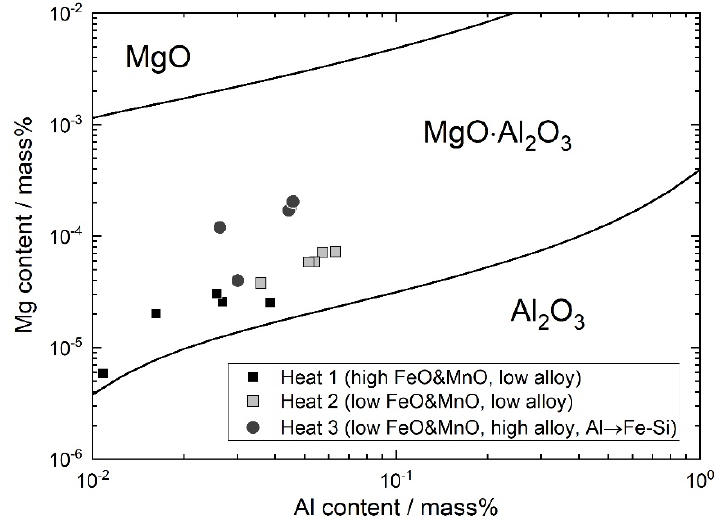
Figure 18. Projection of the steel compositions on the MgO/MgO·Al 2 O 3 /Al 2 O 3 stability diagram.